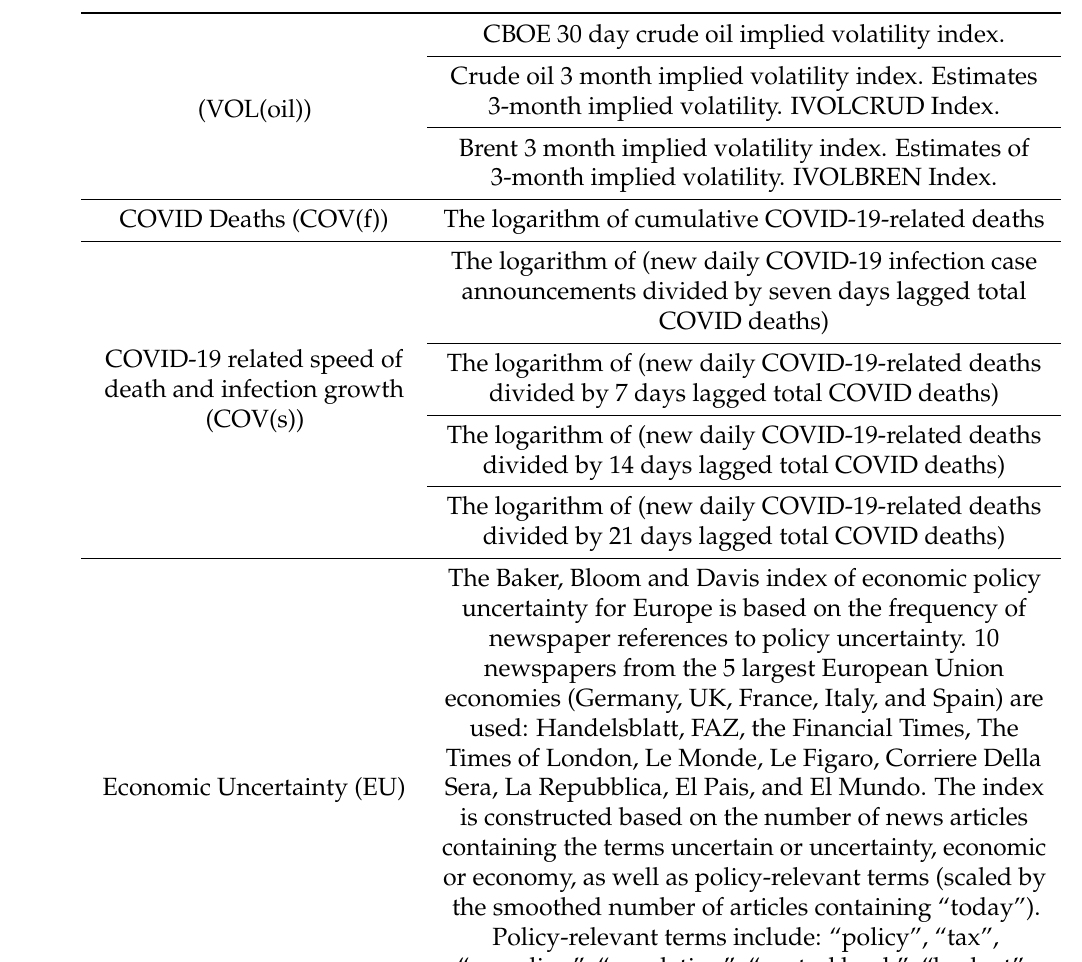
Table A1. Description of variables used in the